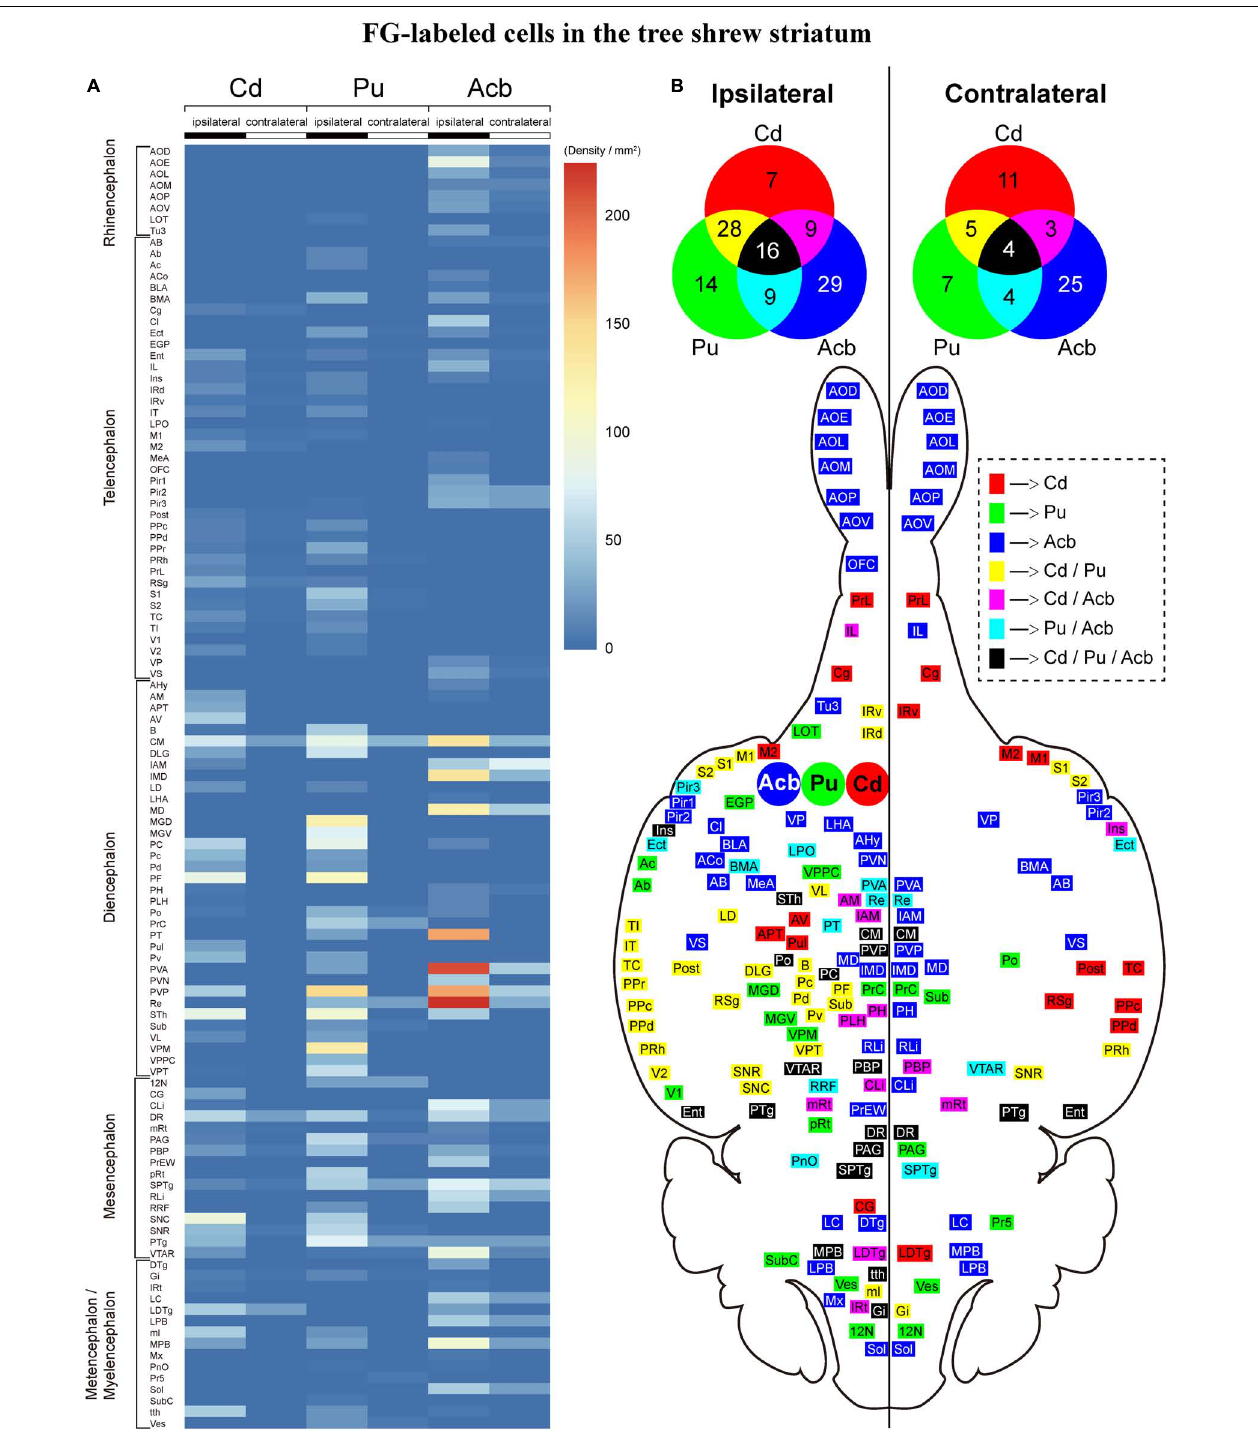
FIGURE 11 | (A) Heatmap showing the density of FG-labeled cells projecting to the caudate nucleus (Cd), putamen (Pu), or accumbens nucleus (Acb) in ipsilateral and contralateral brain regions of tree shrews from rostral to caudal. The color of each box represents the density of FG-labeled cells in each brain region of the rhinencephalon, telencephalon, diencephalon, mesencephalon, metencephalon, and myelencephalon. The color bar indicates the range of density values, with the strongest density shown in red and the weakest density in blue. (B) The Cd-, Pu-, and/or Acb-projecting regions in the ipsilateral and contralateral brain hemispheres are displayed on the horizontal section of the tree shrew brain. The injection sites of the FG retrograde tracer in the Cd (red), Pu (green), and Acb (blue) were located in the left brain hemisphere. Venn diagrams showing the number and overlap of the Cd-, Pu-, and/or Acb-projecting regions in the ipsilateral and contralateral brain